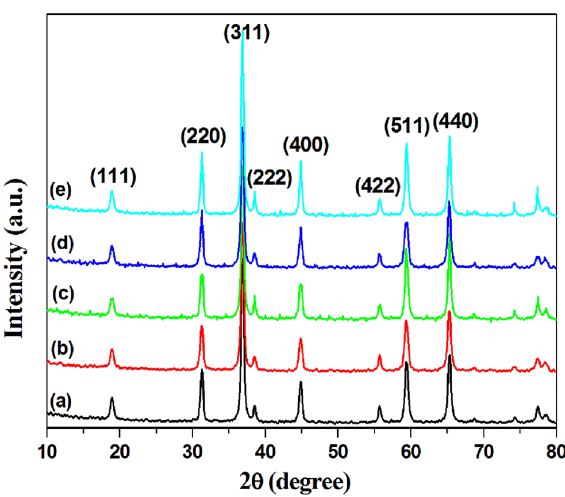
Figure 5. X-ray diffractograms of the pure Co 3 O 4 support (a), and prepared catalysts: Pd n (SG) m /Co 3 O 4 (b),